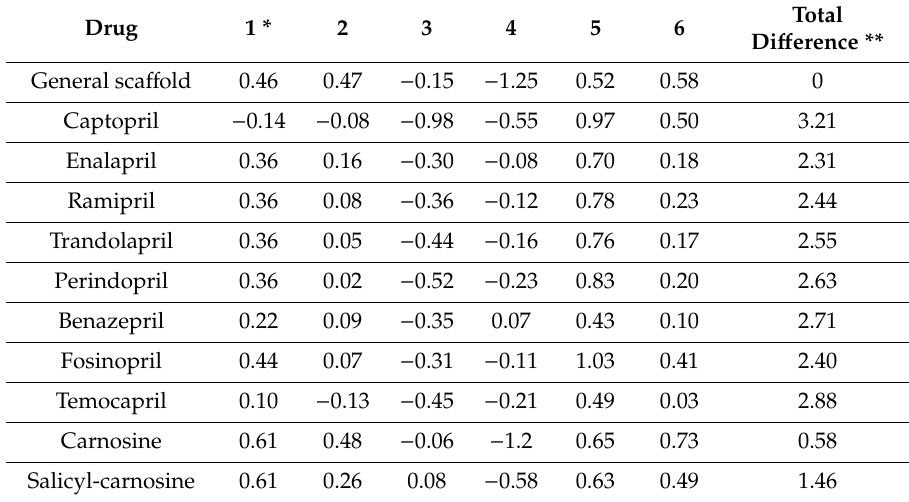
* 1: GPCR ligand 2: Ion Channel Modulator 3: Kinase Inhibitor 4: Nuclear Receptor Ligand 5: Protease Inhibitor 6: Enzyme Inhibitor. ** Total sum of absolute di ff erence at each of the six receptors between the drug and the general sca ff old structure